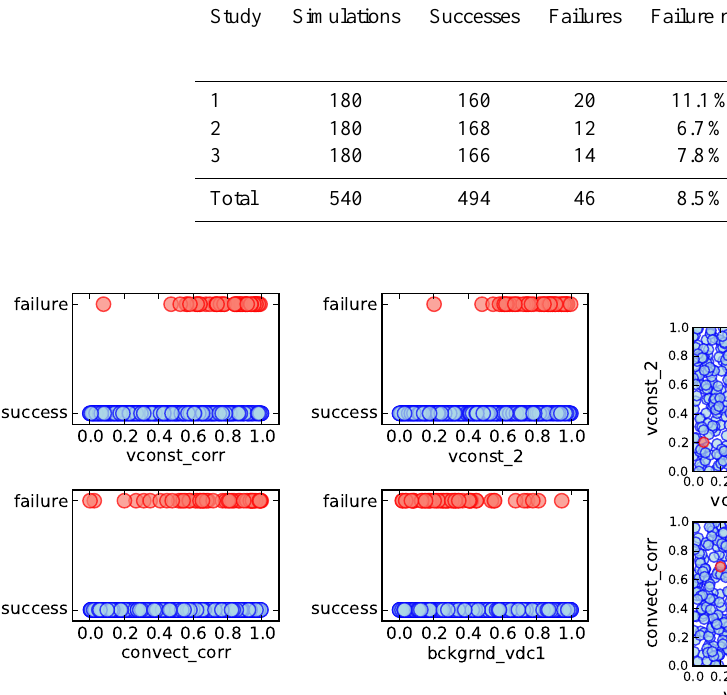
Fig. 1. Climate model simulation successes and failures are shown for one-dimensional projections of the values of 4 ocean parameters in 540 Latin hypercube experiments that sampled 18 model parameters. Parameter values are normalized using the ranges in Table 1.